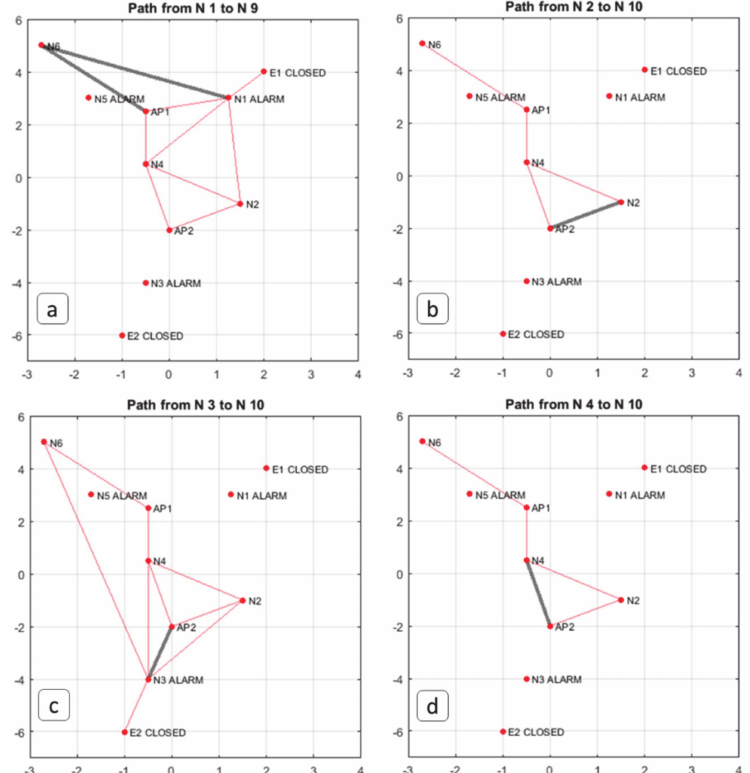
Figure 17. Example of the safest and fastest paths provided by the Algorithm 3 in case of an environmental / structural alarm at nodes 1, 3, and 5 (N1, N3, and N5), which can be used by the people at ( a ) node 1 (N1), ( b ) node 2 (N2), ( c ) node 3 (N3), and ( d ) node 4 (N4) to reach the Assembly Points 1 and 2 (AP1 and AP2, which are also nodes 9, N9, and 10,